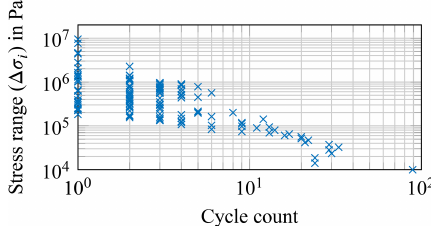
Figure 10. Results of the rain flow cycle count for a 10min inter- val (18 March 2016; 00:10:00). Strain gauge at 315 ◦ , which corre- sponds to fore-aft direction for this interval.